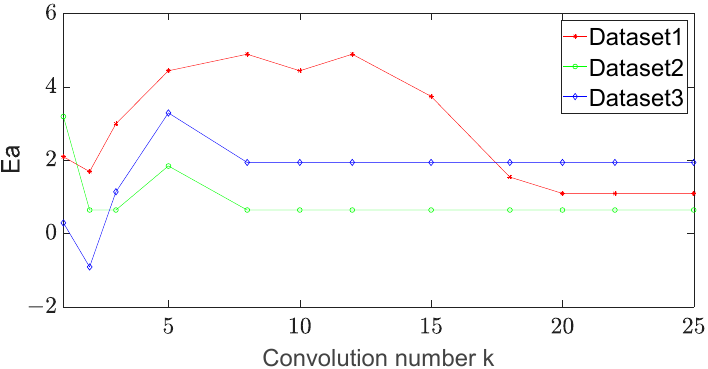
Figure 5. The error of the long axis vs. the convolution number in different datasets.